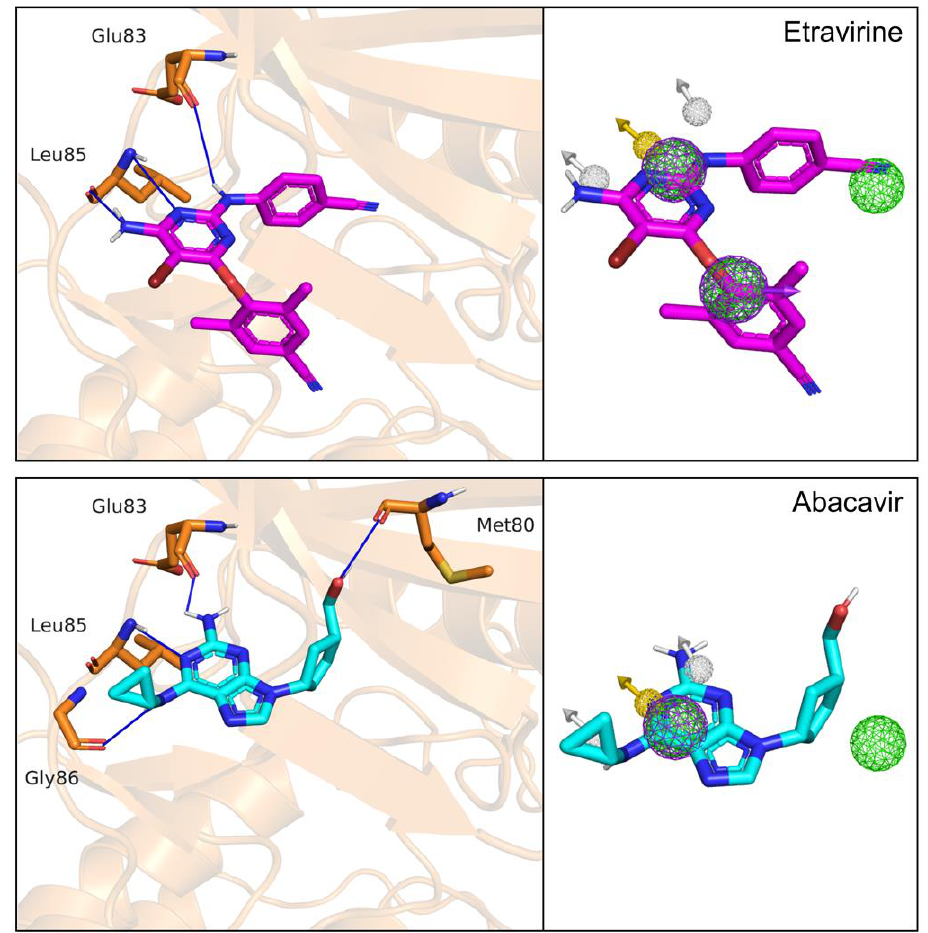
Figure 5. Docking poses of etravirine and abacavir. Overlap of pharmacophore features with the calculated binding modes of etravirine (magenta) and abacavir (cyan). Hydrogen bonds are shown as blue lines. Note that the pharmacophoric submodel used for abacavir lacks the dual element Aro1/Hyd1 (see text for details).